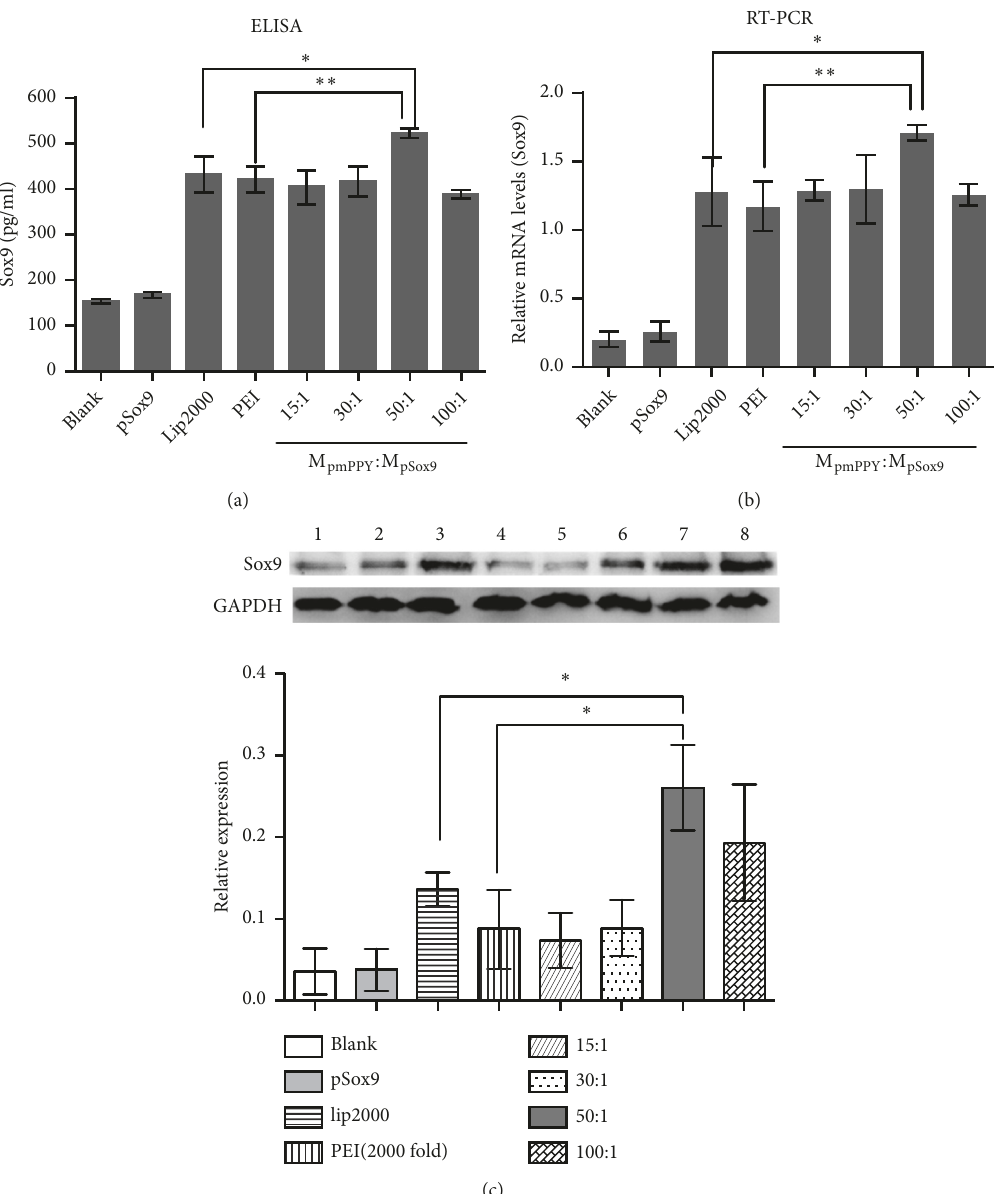
Figure 5: Gene transfection efficiency analyses. Notes. (a) Enzyme-linked immunosorbent assay (ELISA): Lane 1: Blank (cells treated with pmPPY only), Lane 2: Free plasmid Sox9, Lane 3: PEI/pSox9 (2000-folds of dilution), Lane 4: Lipofectamine 2000 /pSox9, Lane 5-8: pSox9/pmPPY nanoparticles in ratios of 15:1, 30:1, 50:1, and 100:1;(b) RT-PCR, Lane 1: Blank (cells treated with pmPPY only), Lane 2: Free plasmid Sox9, Lane 3: PEI/pSox9 (2000-folds of dilution), Lane 4: Lipofectamine 2000 /pSox9, Lane 5-8: pSox9/pmPPY nanoparticles in ratios of 15:1, 30:1, 50:1, and 100:1 (c) Western Blot, Lane (1-4): Blank (cells treated with pmPPY only), Free plasmid Sox9, Lipofectamine 2000 /pSox9, PEI (2000-fold dilution)/pSox9, Lane 5-8, pmPPY-pSox9 nanoparticles prepared at different weight ratios 15:1, 30:1, 50:1, and 100:1, from left to right; and a quantitative analysis of the relative expression levels of Sox9 (mean ± standard deviation of measurements from three replicates) ∗ P < 0.05, ∗∗ P <